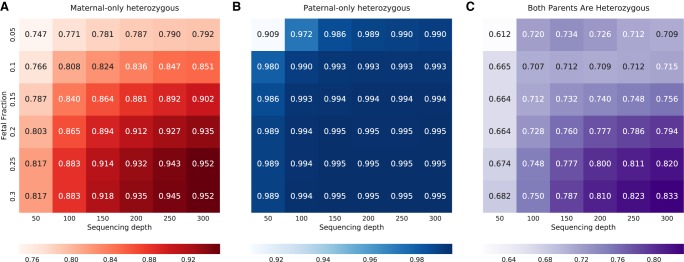
Performance of the model in SNPs, with different depths and fetal fractions. Heat maps A–C present the accuracy as a function of both the median sequencing depth and the fetal fraction, at the three categories of loci.